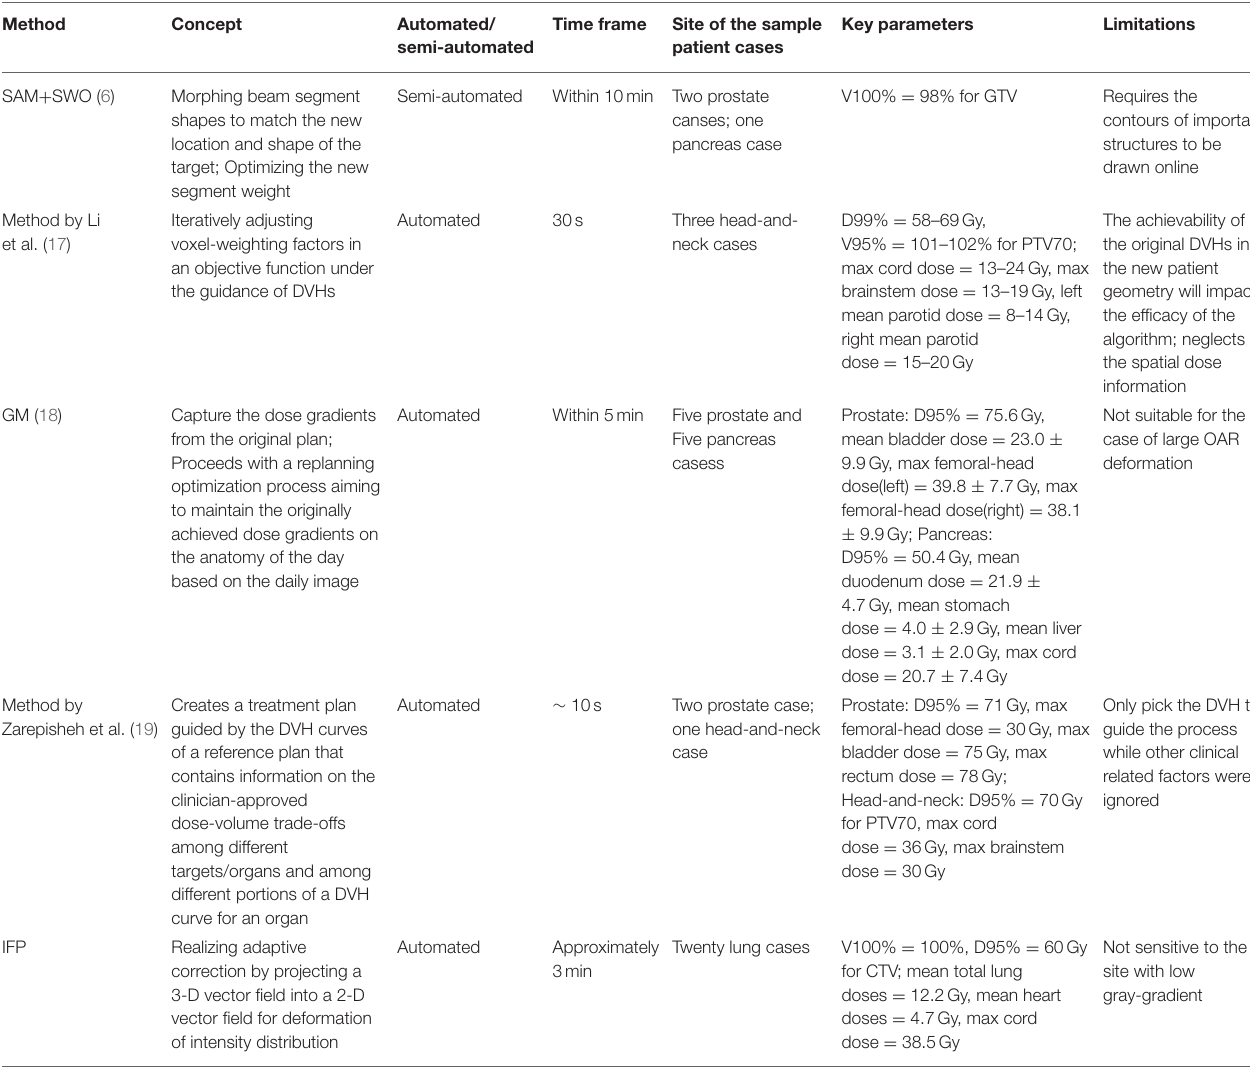
TABLE 2 | Comparison between the IFP and other algorithms.